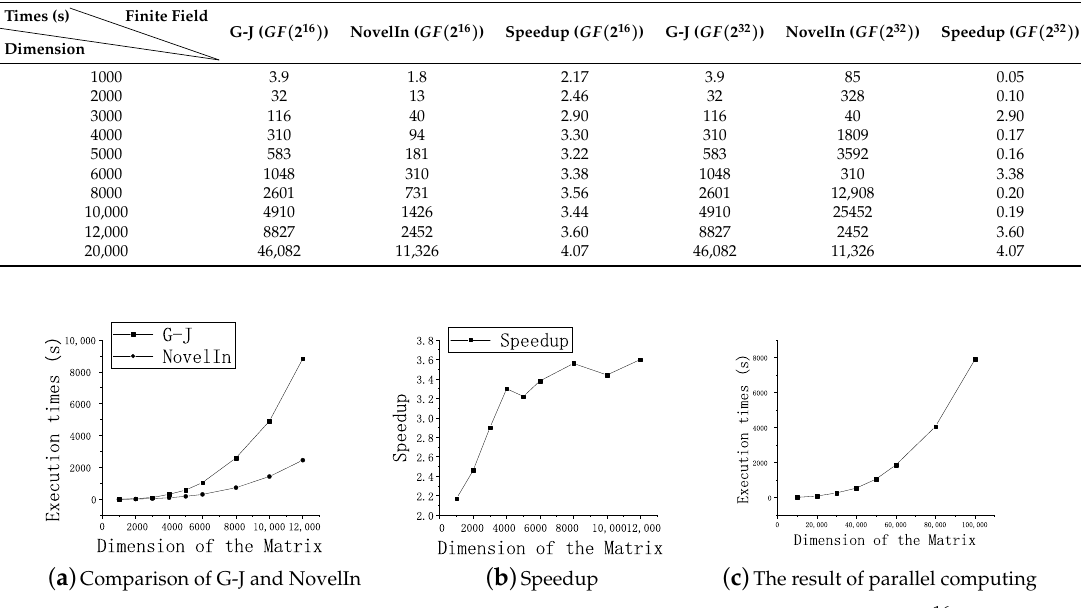
Table 4. The results on GF ( 2 16 ) and GF ( 2 32 ) .